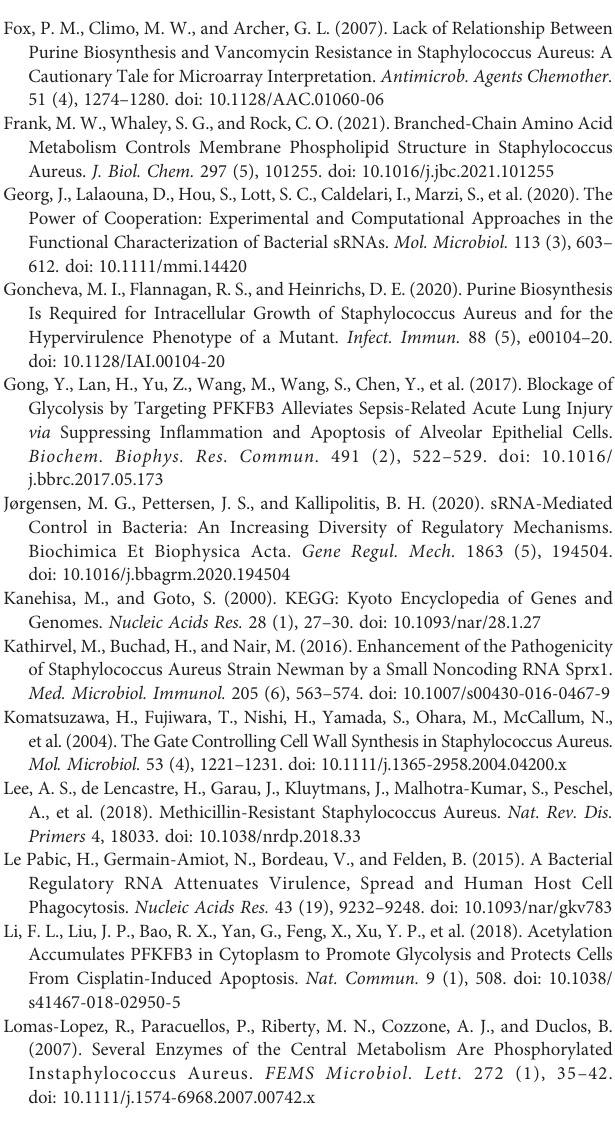
Supplementary Table 1 | The primer pairs used for the validation of DEGs expression. Supplementary Table 2 | DEGs in N315 D sprC and N315 strains. Supplementary Table 3 | Statistical analysis of differential ions quanti fi cation data. Supplementary Sequencing Data | Partial sequence of